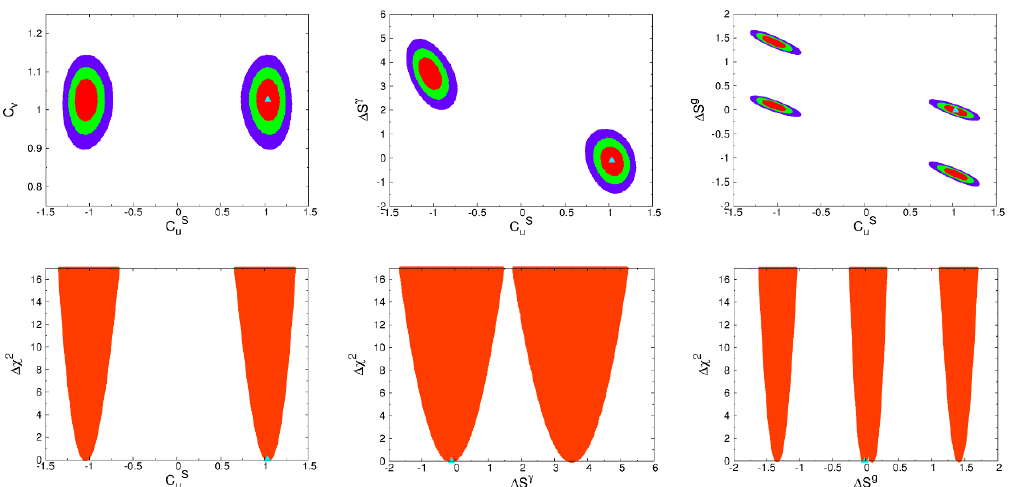
, u (left), (cid:1) (cid:31) 2 versus (cid:1) S (cid:13) u